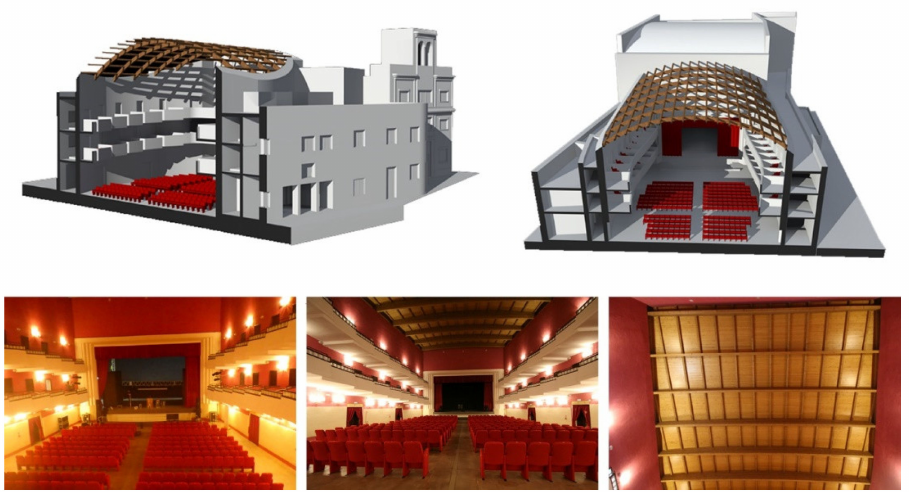
Figure 3. Combo 01—Wooden roof without false